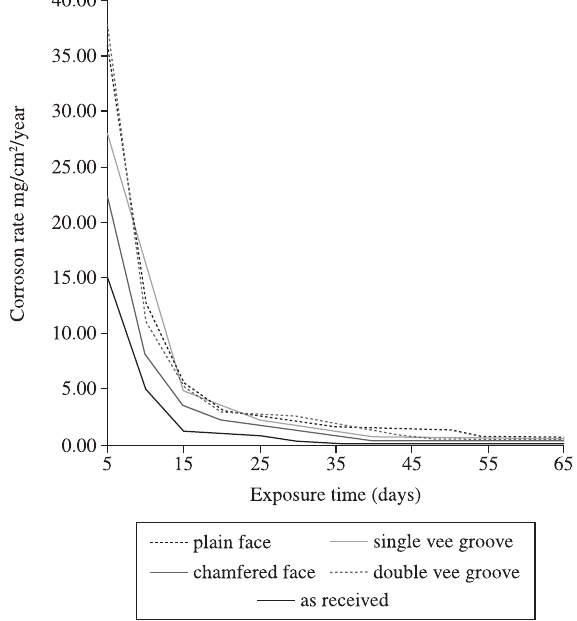
Figure 2. Plot of corrosion rate vs. exposure time of austenitic stainless steel welded at various weld geometry.